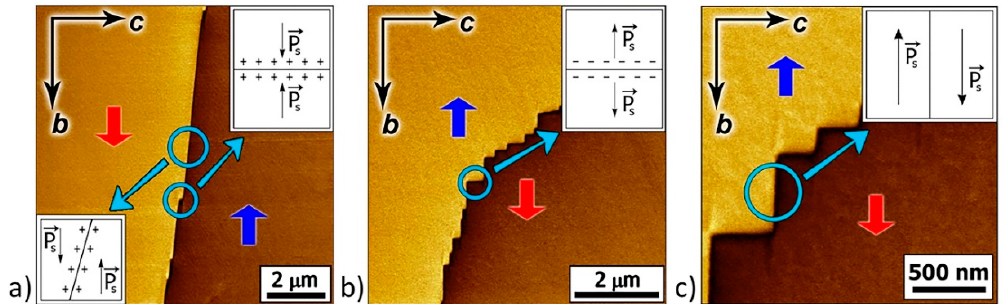
Figure 2. PFM images of the domain walls. Three types of the domain wall fragments: Charged ( a ) head-to-head, ( b ) tail-to-tail, and ( c ) neutral. Lateral PFM contrast. Red and blue arrows indicate the direction of spontaneous polarization within domains. Arrows b and c show the directions of crystal axis.